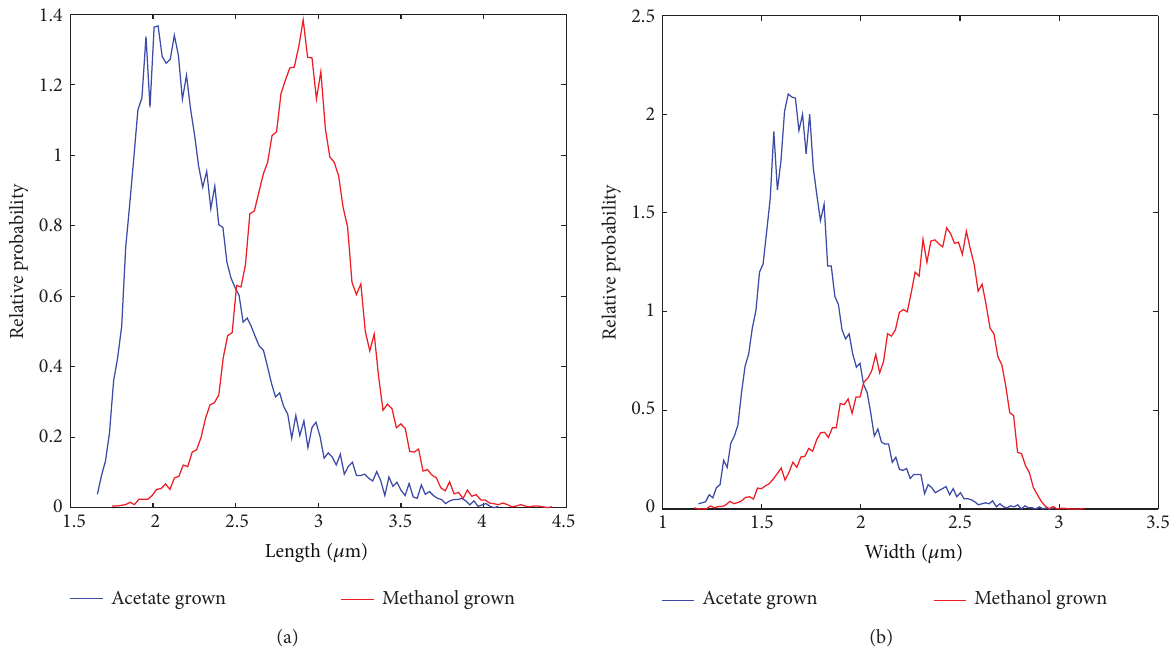
Figure 6: Distributions of (a) lengths and (b) widths of single M. acetivorans cells grown on methanol (red) and acetate (blue) as determined by DIC microscopy and image analysis. Data corresponds to approximately 10,000 cells.